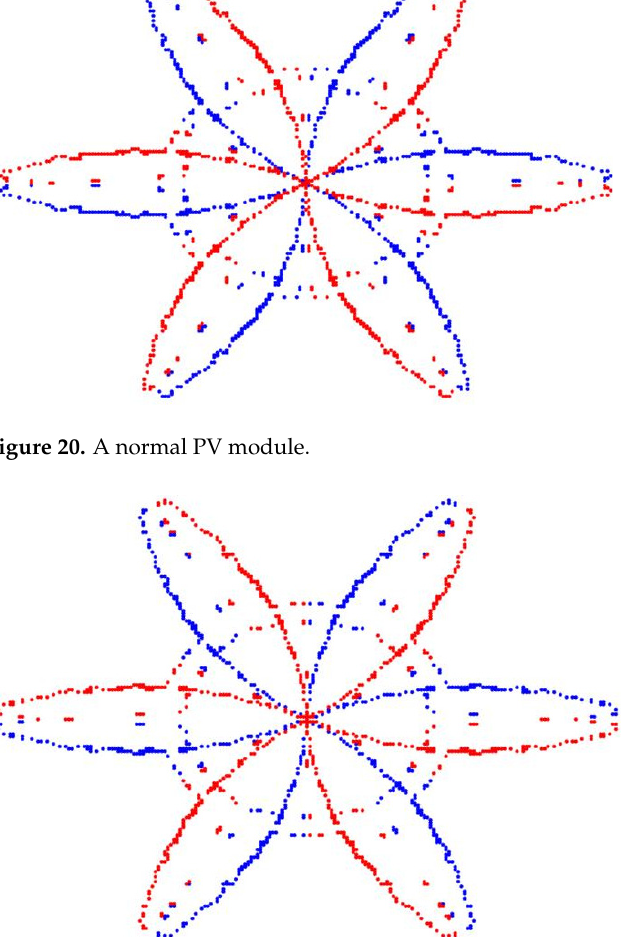
Figure 22. A PV module breakage .